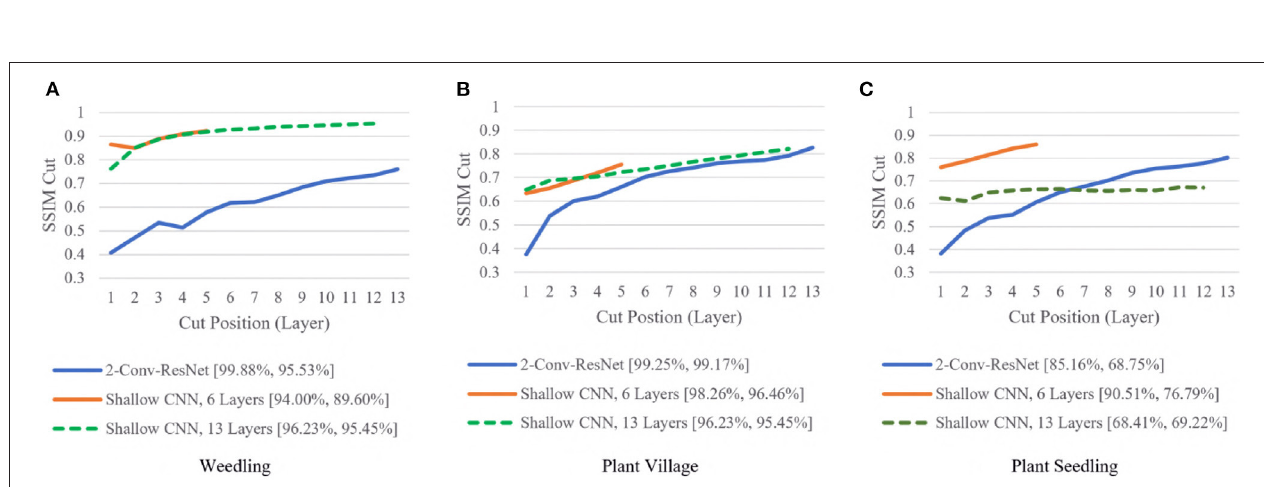
FIGURE 5 | Comparison of the Cut Position (Layer) VS SSIM cut curve for ResNet models for (A) Weedling and (B) Plant Village dataset for Epoch (Best).